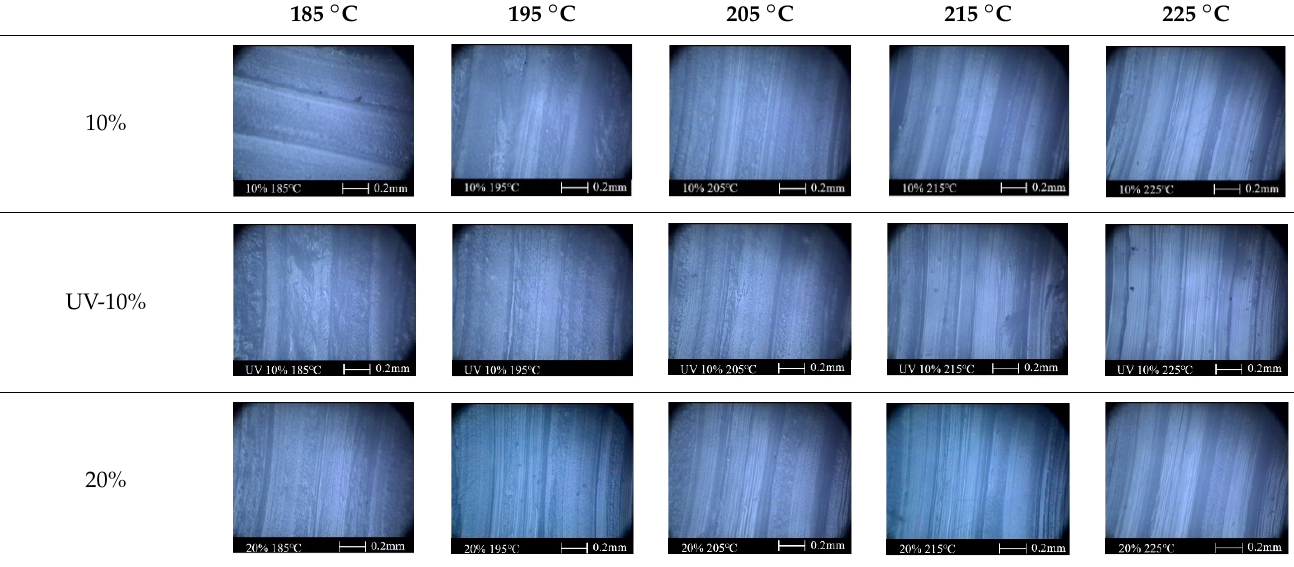
Figure 8. Tensile test specimens with different filling percentages ( a ) 10%, ( b ) 20%, ( c ) 33.3%, and ( d ) 50% under various printing temperature conditions after UV curing. Table 8. Surface morphology of the specimens before and after UV curing.